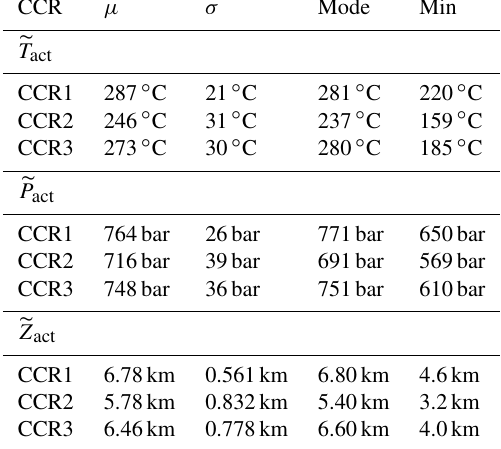
Table 3. Mean ( µ ), standard deviation ( σ ), mode and minimum value associated with the sample pdfs of (cid:101) T act , (cid:101) P act and (cid:101) Z act . Statis- tics are computed for CCR1, CCR2 and CCR3. The maximum val- ues of (cid:101) T act , (cid:101) P act and (cid:101) Z act are not listed as they correspond to the maximum temperature, pressure and depth observed in the selected setting, independent of the target CCR mechanism. CCR µ